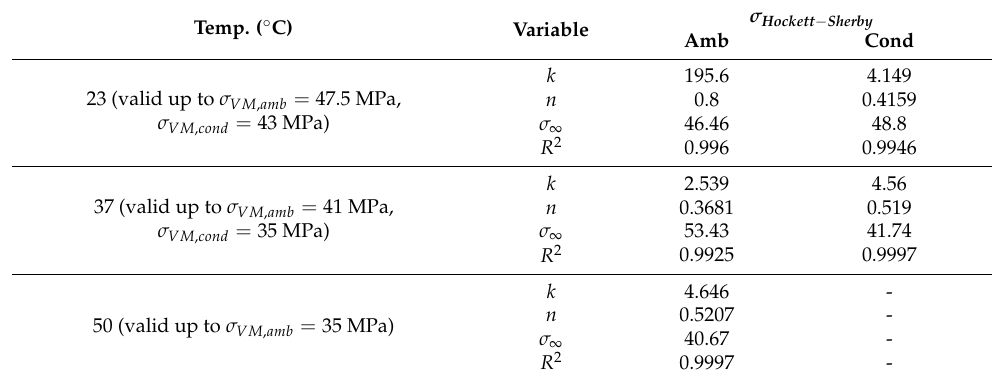
Table 3. Fitted variables of the Hockett–Sherby model until necking for 23 °C (Ambient and Conditioned), 37 °C (Ambient and Conditioned), and 50 °C (Ambient) R 2 . Temp. (°C)